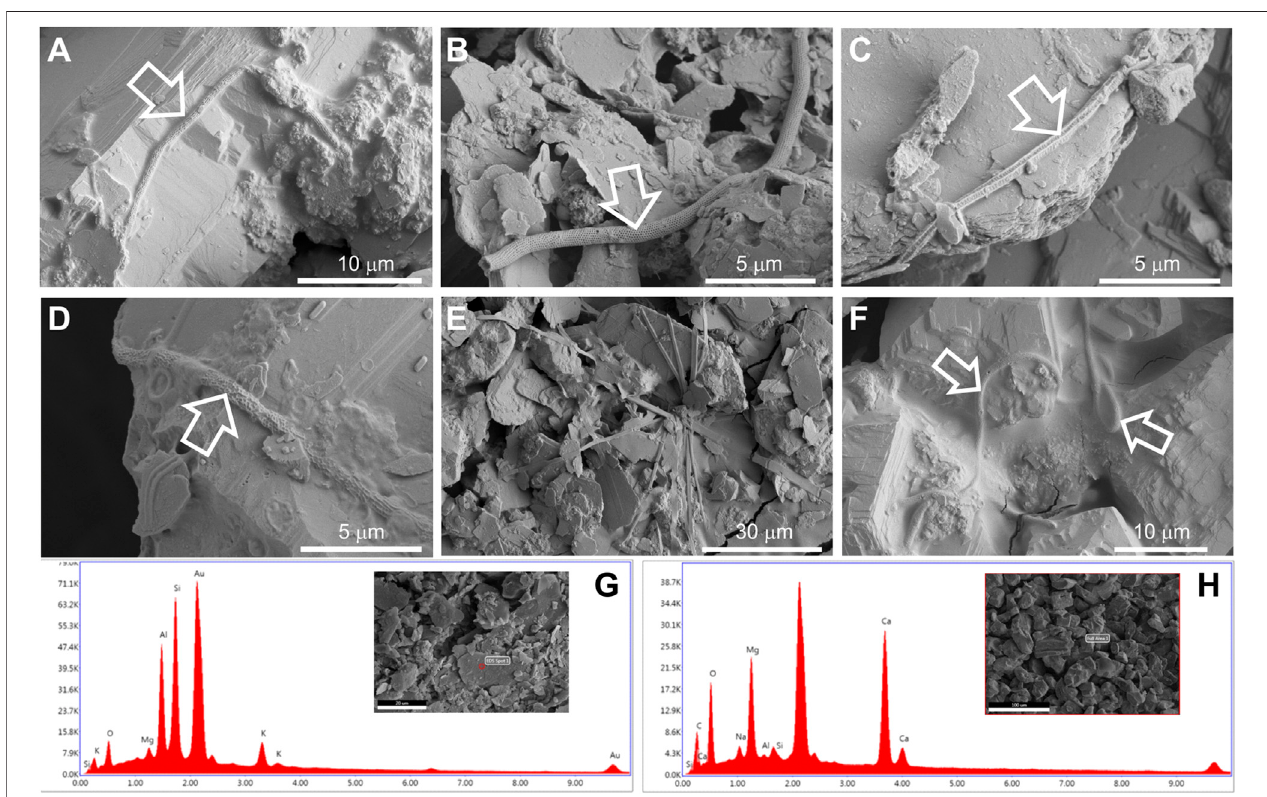
FIGURE3| FESEMimagesfromsamplesM1 (A) ,M3 (B , C) ,M4 (D) ,M5 (E) ,andM6 (F) depictingmicrobialstructuresassociatedwithvermiculations.FESEMwith corresponding EDS spectra from sample M5 (G) denotes the presence of clay minerals, due to the abundance of Al and Si, and sample M6 (H) , rich in Ca and Mg, of